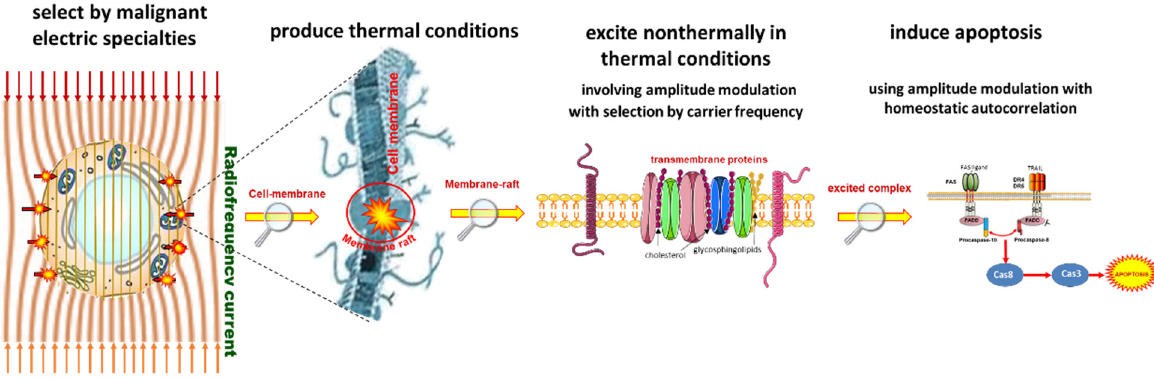
Figure 5. The transmembrane proteins of malignant cells absorb the energy in thermal and nonther- mal forms. The amplitude-modulated carrier frequency’s nonthermal effect gives the apoptotic signal pathway (see below in results). The carrier frequency delivers the modulated signal and selects the malignant cells, while the modulation with homeostatic autocorrelation (time-fractal) constrains the apoptotic pathway.